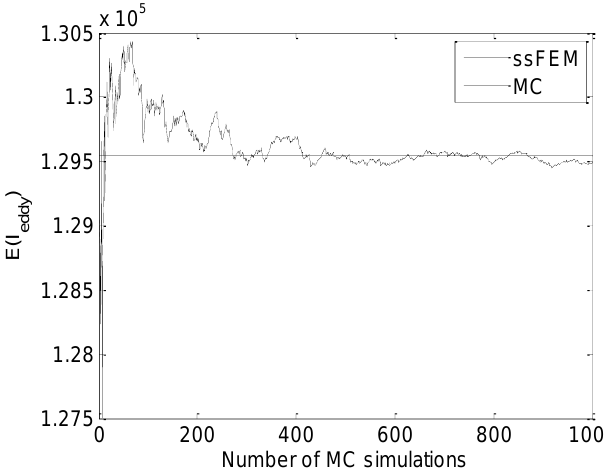
Fig. 7. Mean values of the total induced eddy currents calculated with the Monte Carlo method and with